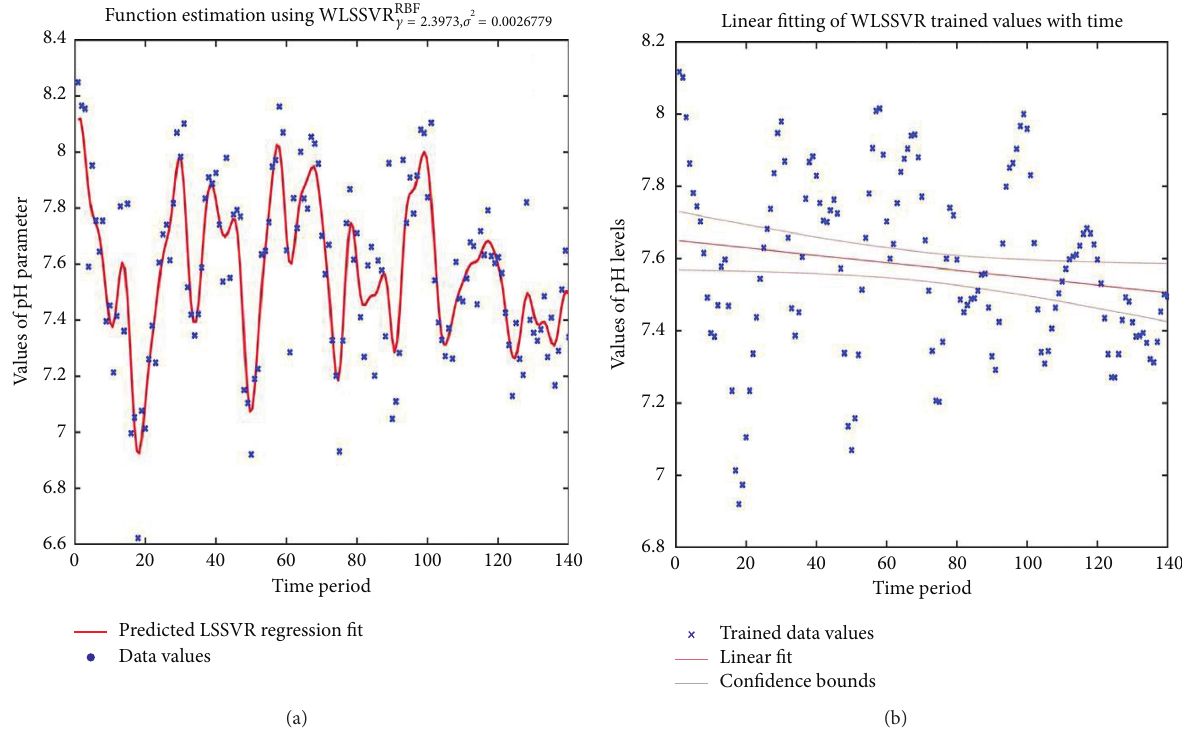
Figure 15: (a) WLSSVR regression fit of pH values at Bridge. (b) Linear regression fit of WLSSVR trained pH values at Bridge.